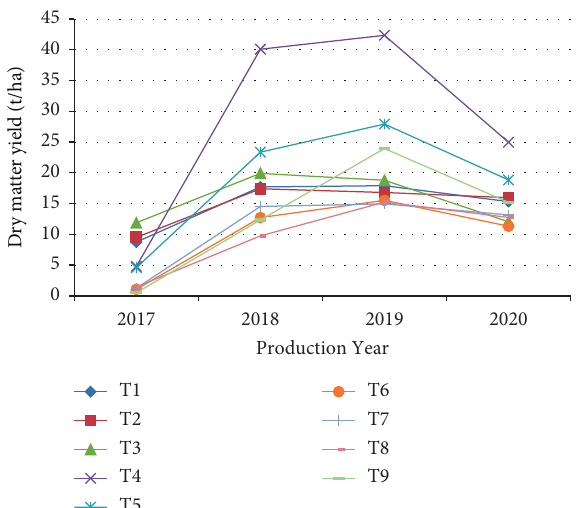
Figure 1: Forage dry matter yield performance of different (t/ha) perennial species under irrigation supplementation. Table 6: Crude protein yield (t/ha) of perennial forage grass species evaluated under irrigation supplementation. Species